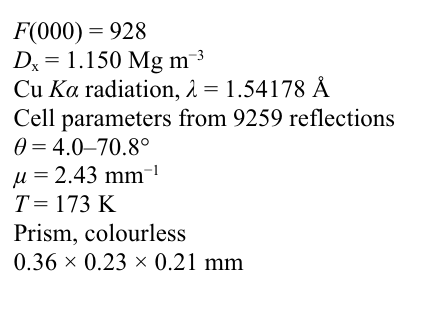
The crystal structure viewed along the [001] direction, showing four Cl - anions spaced between four DIPA + cations. 2,6-Diisopropylanilinium chloride Crystal